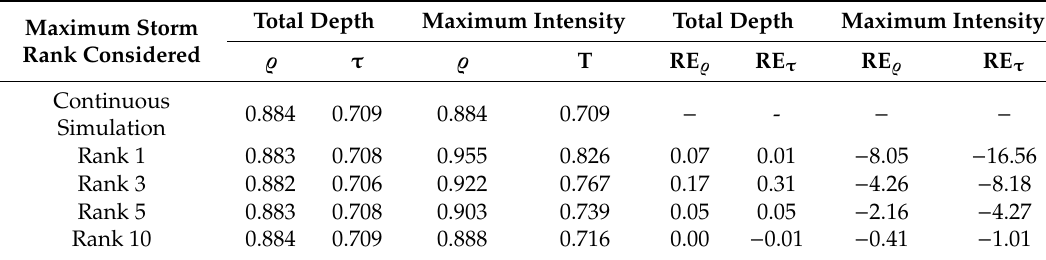
Table 6. Parameters of the Archimedean copula estimation from the pair of values of maximum annual peak-flows and maximum annual volumes of the continuous simulation, with the root mean square error (RMSE) and Nash–Sutcliffe error (NSE). Copula